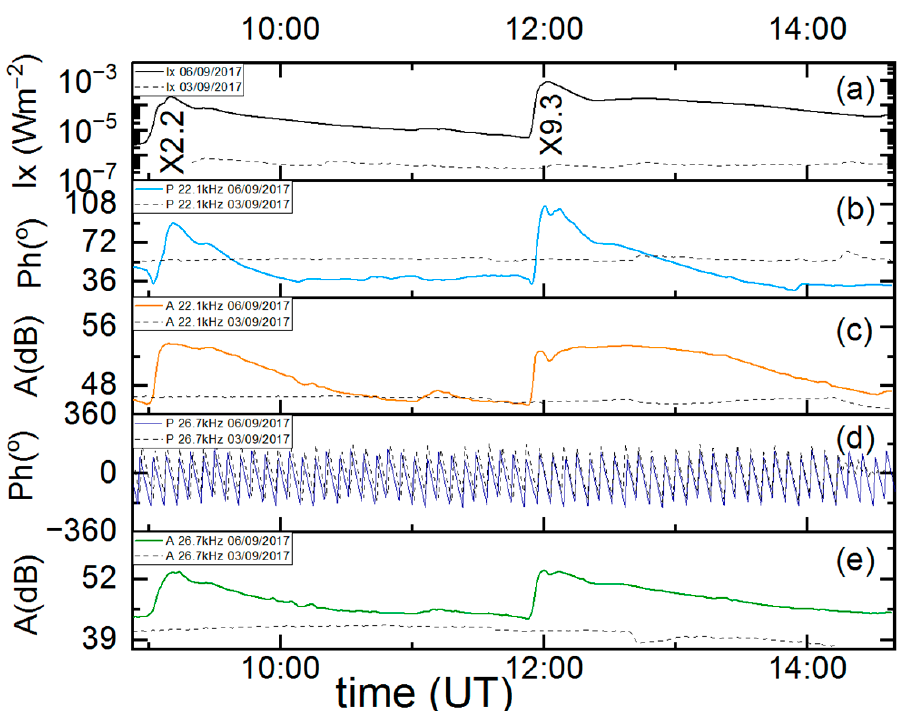
Figure 3. Simultaneous variations of X-ray flux ( a ) with phase delay, ( b ) amplitude delay, ( c ) variations of GQD/22.10 kHz and phase delay, ( d ) amplitude delay, ( e ) variations of TBB/26.70 kHz signals versus universal time UT during occurrence of X2.2 and X9.3 class SFs of 6 September 2017. Observed amplitude and phase perturbations with the quiet signal of 3 September 2017 (dashed black) are measured at Belgrade station. Time variation of soft X-ray irradiance is measured by GOES-15 satellite.